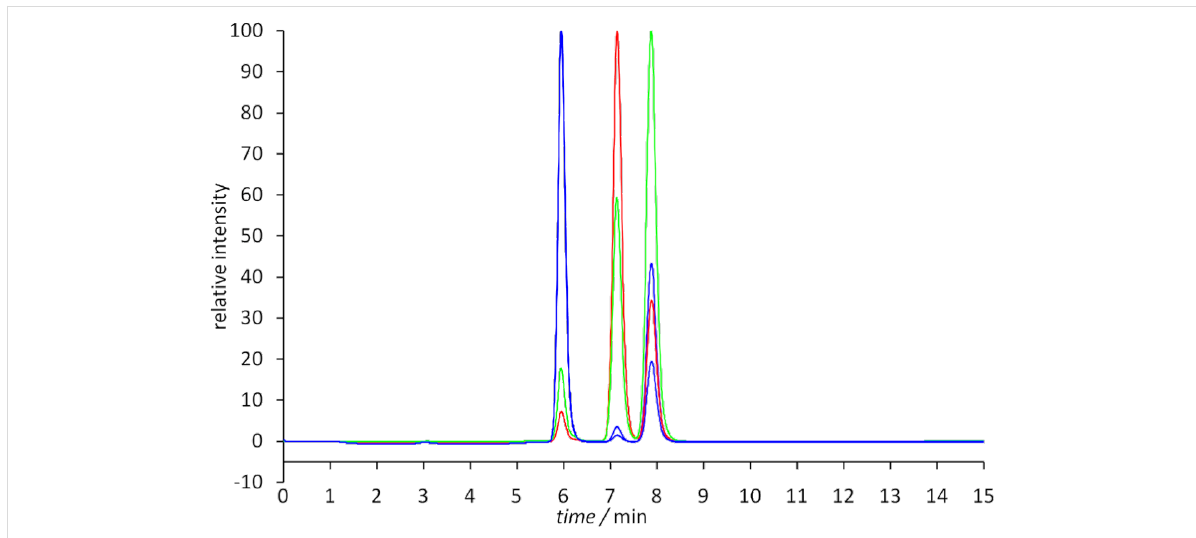
Figure 6: HPLC spectra (ReproSil Phenyl, 5 μ m, 250 × 8 mm; methanol) of trans , trans - 10 (blue), cis , trans - 10 (green) and cis , cis - 10 (red) 20 min after isolation by means of HPLC.